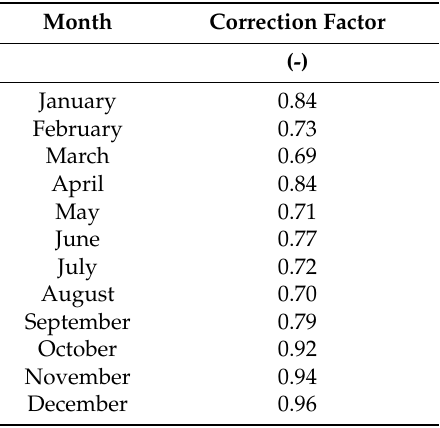
Table 5. Monthly correction factors calculated after Peng and Stovin [18] for the time series climate records (1990–2015) of Villa Cambiaso (Genoa,